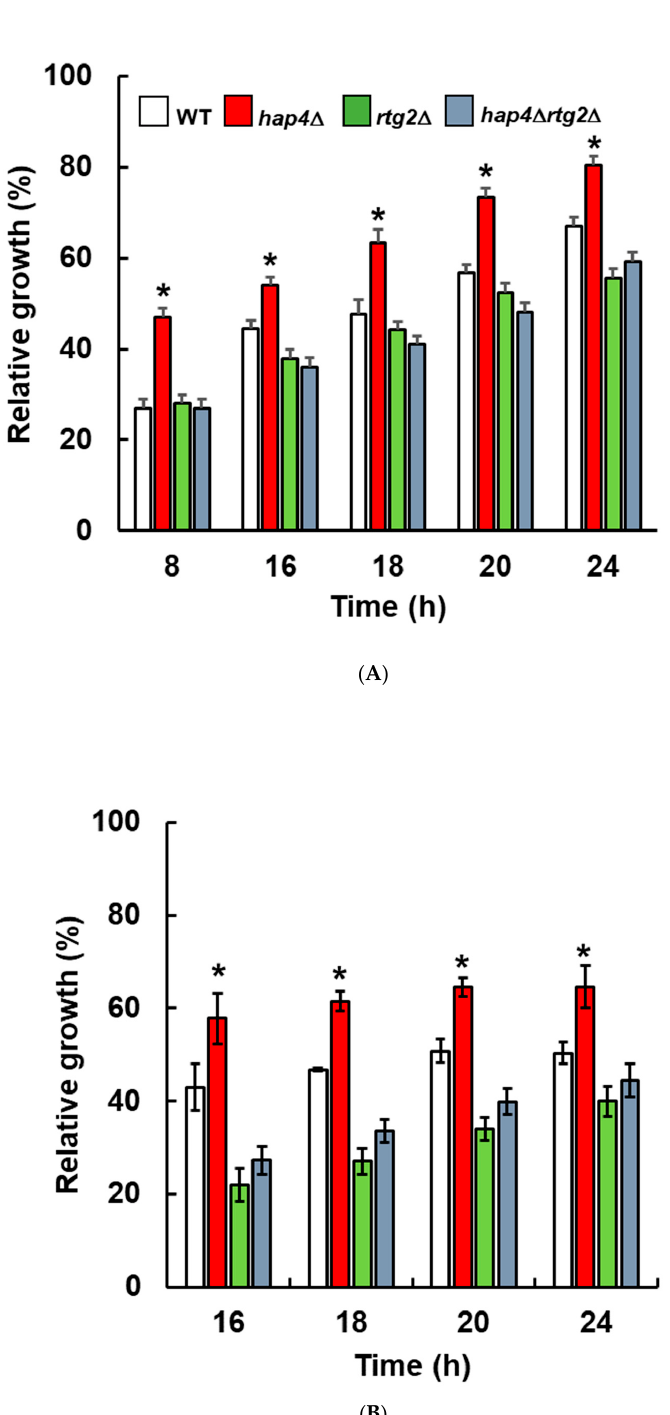
Figure 2. Relative growth of wild type and mutant cells in the presence of NaCl. ( A ) Wild type (WT) and indicated mutant cells (hap4 ∆ , rtg2 ∆ , hap4 ∆ rtg2 ∆ ) grown overnight in YPD were diluted to 0.01 OD600 in fresh liquid YPD with or without 0.8 M sodium chloride (NaCl), and optical density was measured at 600 nm (OD600) over time with a high-precision TECAN microplate reader. ( B ) Wild type (WT) and indicated mutant cells (hap4 ∆ , rtg2 ∆ , hap4 ∆ rtg2 ∆ ) grown overnight in YPD were diluted to 0.1 OD600 in fresh liquid YPD batch cultures with or without NaCl 0.8 M and optical density (OD600) was measured at the indicated times. In both ( A , B ), relative growth was calculated as the percentage of the OD600 of stressed/control cells. Unpaired Student’s t -test: a statistically significantly difference with * p < 0.01 when comparing wild type versus hap4 ∆ cells from three independent